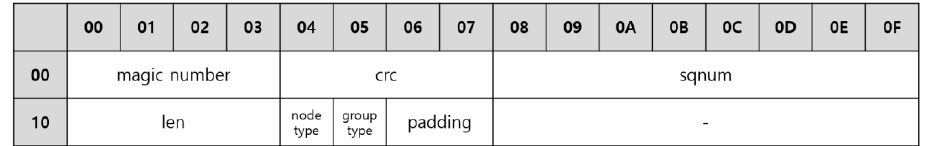
Figure 13. UBI common header in form of hex value.